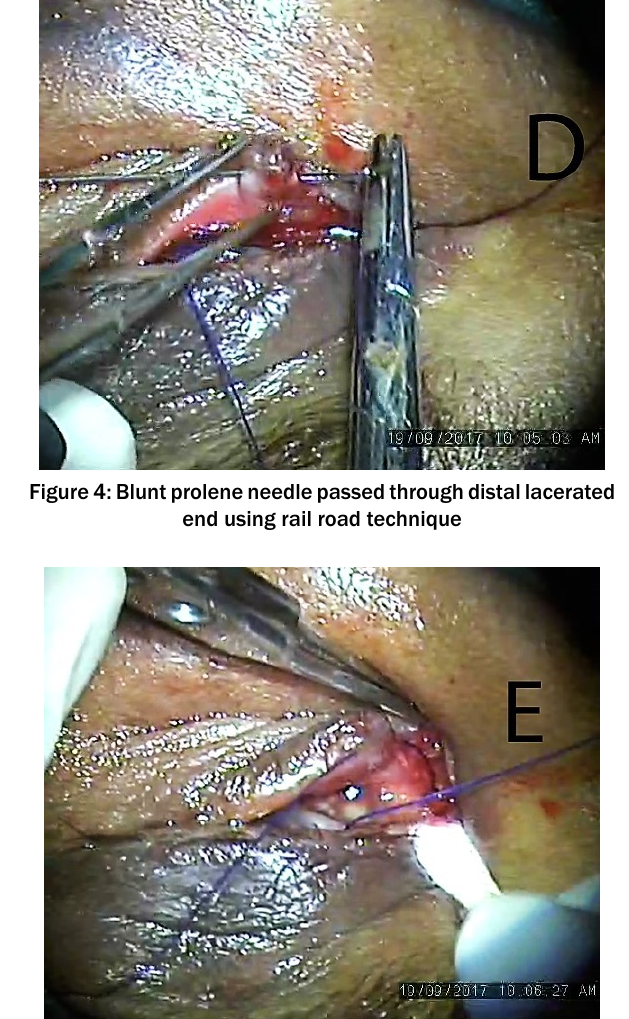
Figure 5: Prolene suture passed and loop created